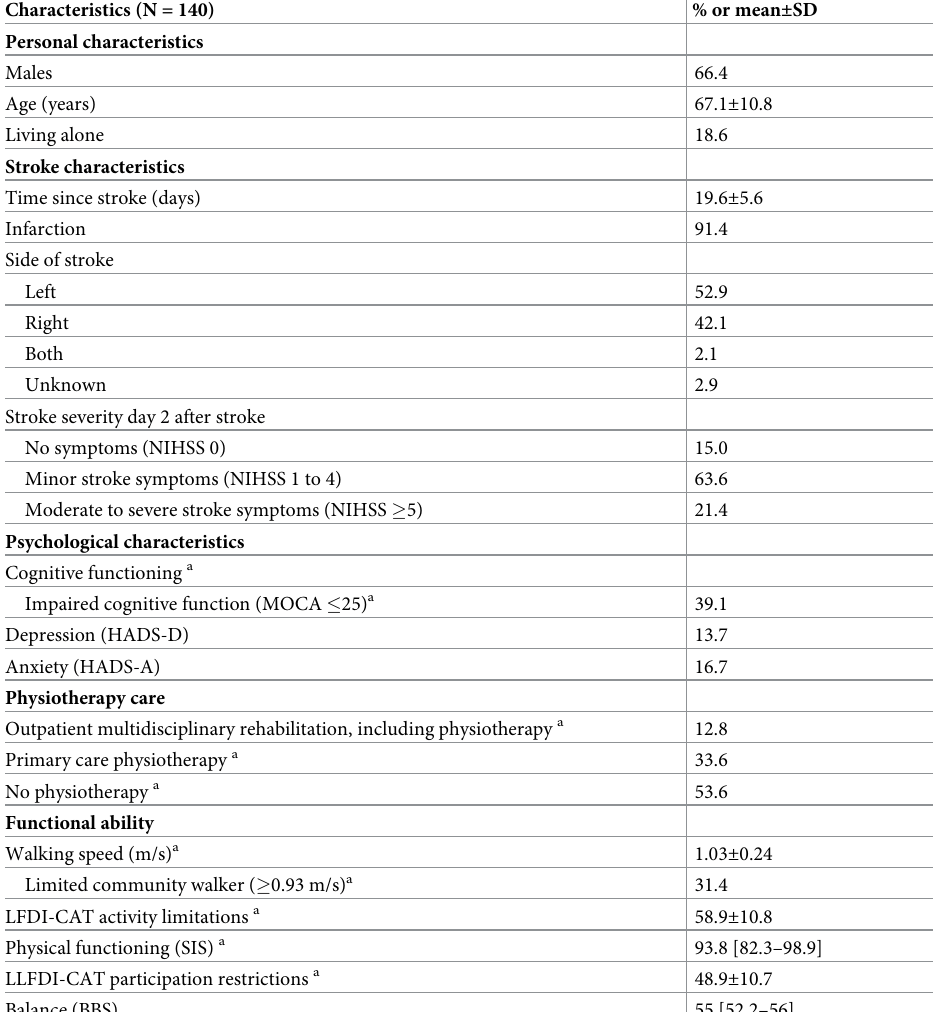
Table 1. Participant characteristics expressed as mean ± SD, median [IQR], or n (%). Characteristics (N =